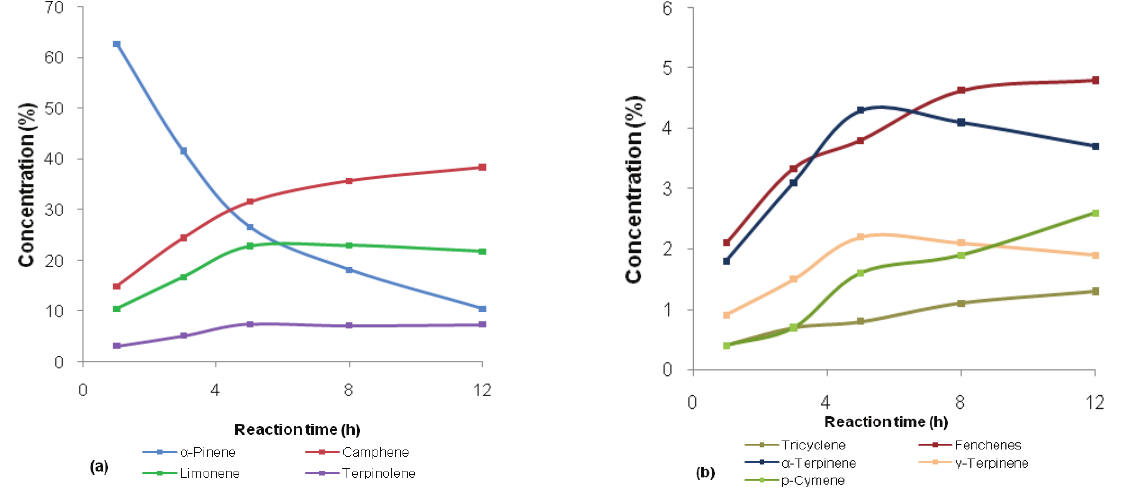
SiW O /SiO catalyst 4 12 40 2